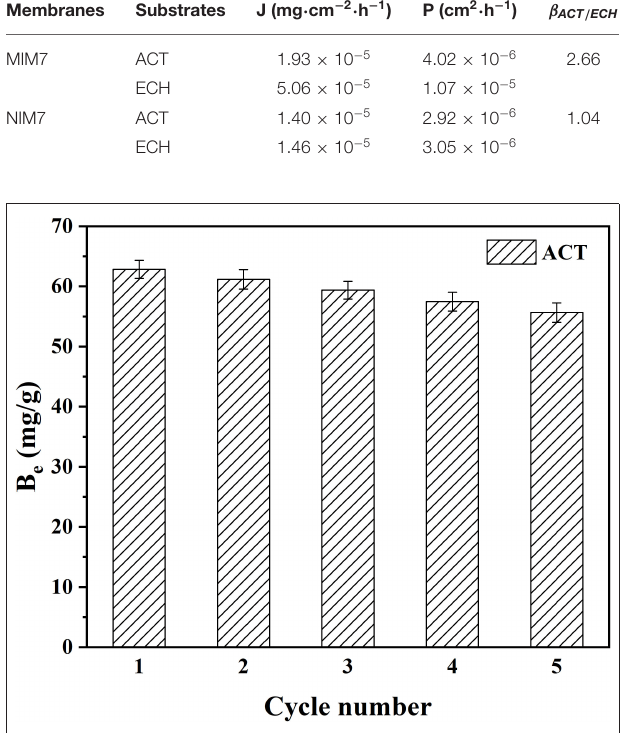
FIGURE 7 | Adsorption-desorption cycles of MIM7 for ACT adsorption.